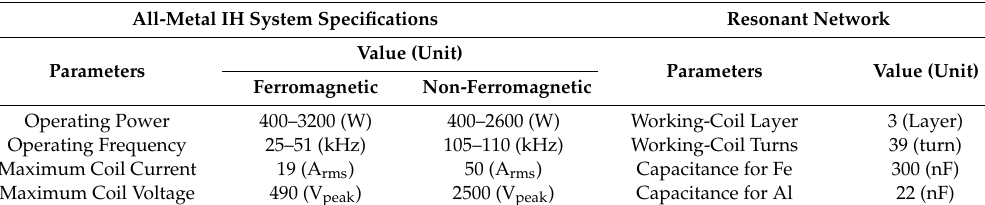
Table 2. Specification of all-metal IH system.